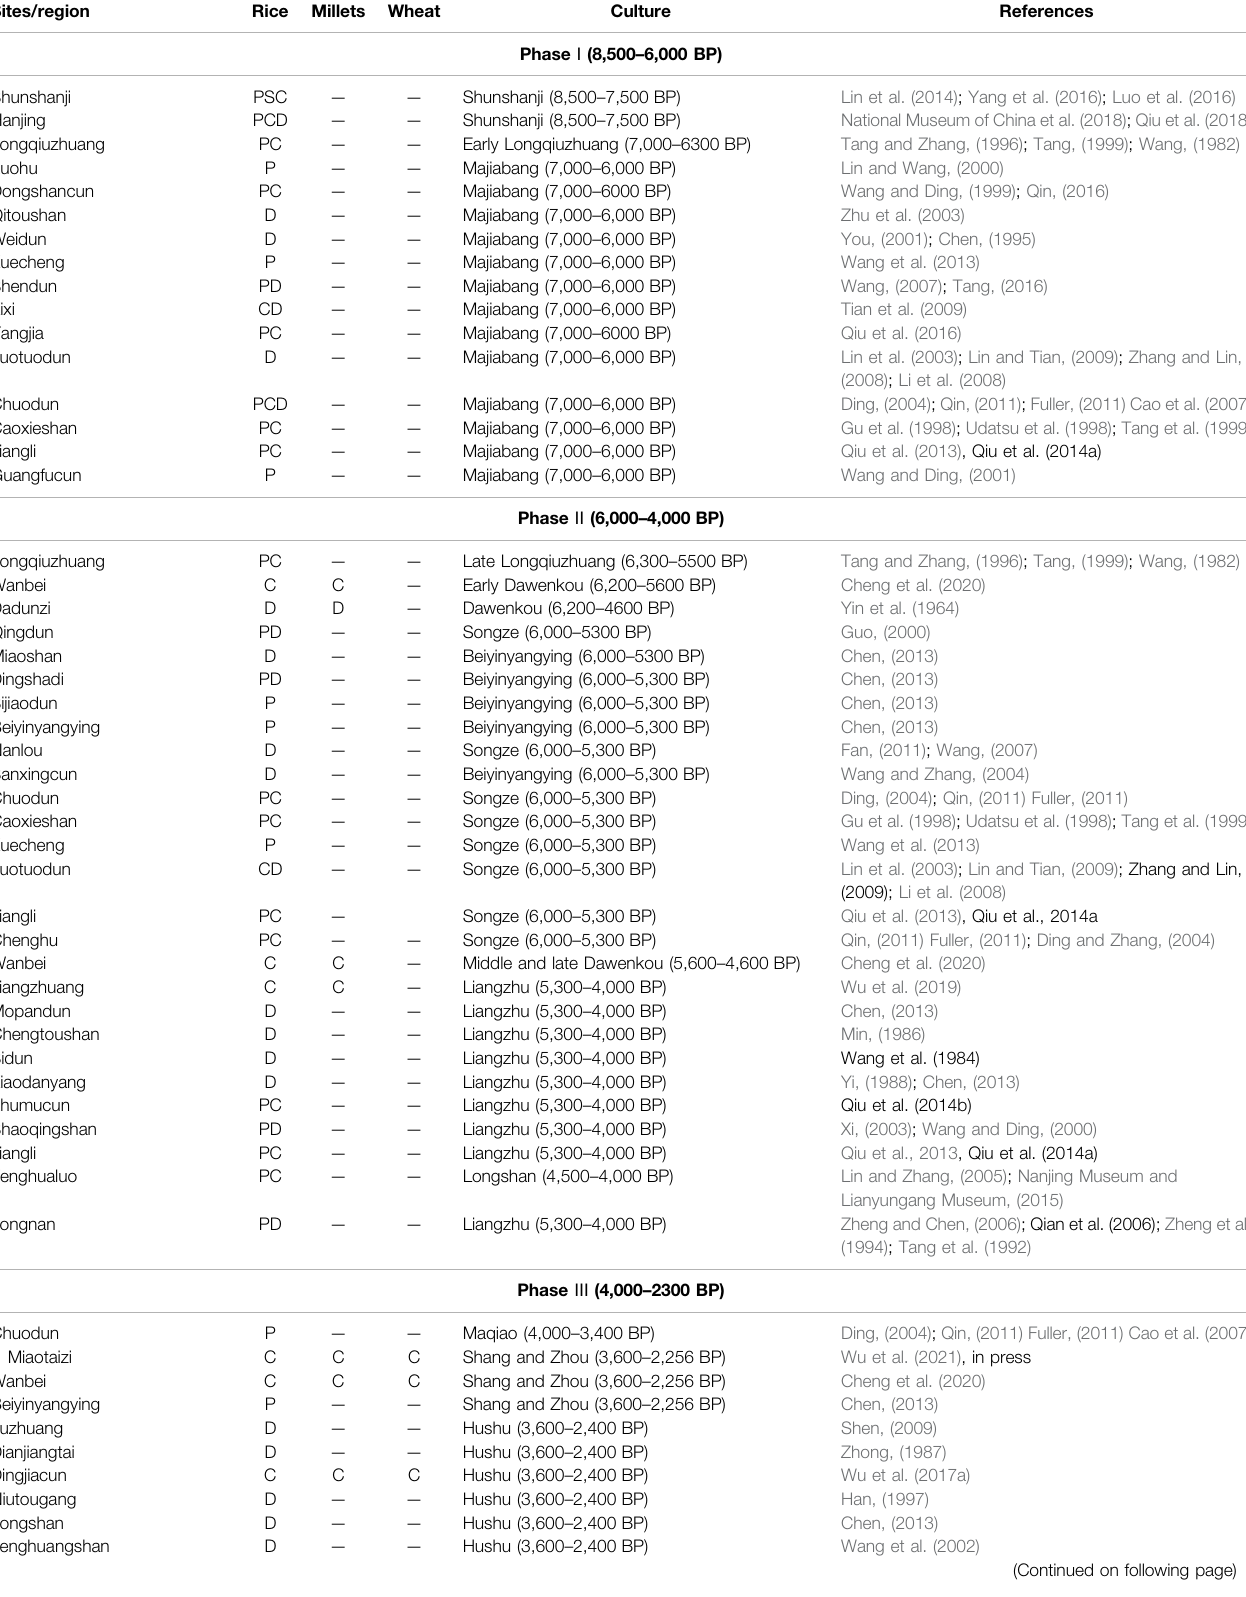
TABLE 1 | Botanical evidence of major crops in Holocene in Jiangsu Province, Eastern